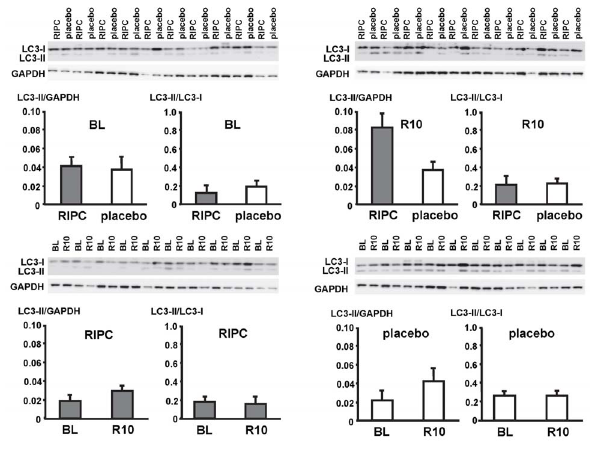
Figure 6. Expression of p62. Original Western blots of protein content of p62 in myocardial biopsies obtained at baseline (BL) before initiation of cardiopulmonary bypass and at 5–10 min reperfusion (R10) from patients undergoing remote ischemic preconditioning (RIPC) or not (placebo). Immunoreactivity of p62 was normalized to glyceralde- hyde 3-phosphate dehydrogenase (GAPDH). Ratios are presented in bar graphs.